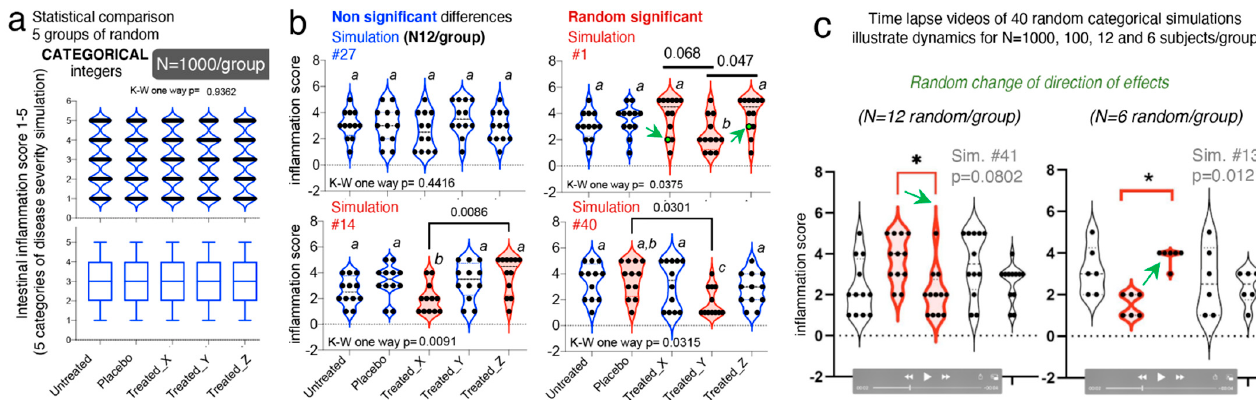
Figure 6. Categorical data simulations and violin plots illustrate that integer data exhibit multimodality and affect statistical reproducibility as simulations are performed randomly with various N. ( a ) N = 1000/group, simulation #1, violin plot and correspondent box plot for nonsignificant expected similarity across five groups (one-way K-W p > 0.05). See p -values and violin plots for >40 consecutive simulations in Supplementary Figure S7. ( a,b ) N = 12/group, violin plots for simulations #27 (non-significant), and #1, #14, and #40 (significant) illustrate comparisons due to randomness, result in irreproducible “treatment effects” and “direction of effects”. Arrows, data points with statistical influence (see boxplots in Supplementary Figure S7). ( c ) Screenshots of time-lapse videos to show dynamically how statistical irreproducibility occurs at random for various N. Arrows indicate direction of effect. See Supplementary Video S1 doi:10.6084/m9.figshare.13377407. Asterisks indicate significance P < 0.05.